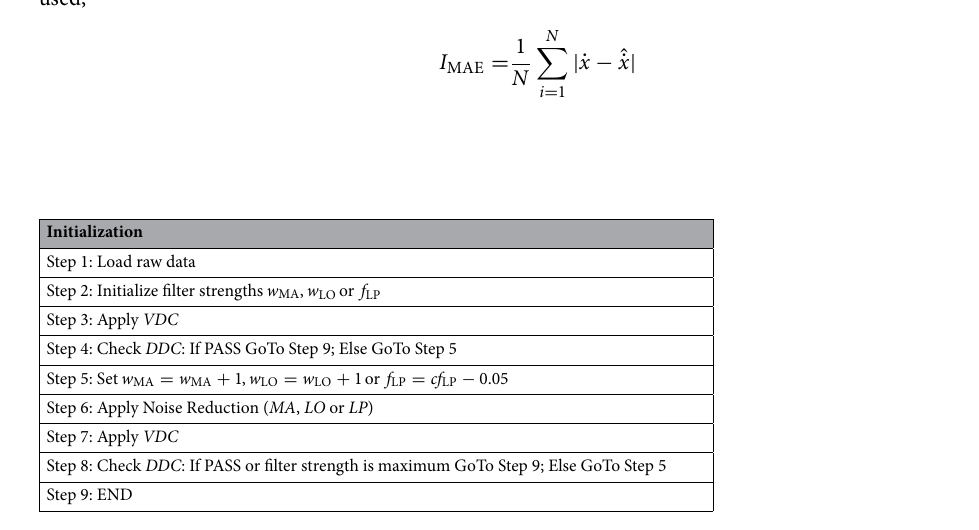
Table 3. High-level algorithmic